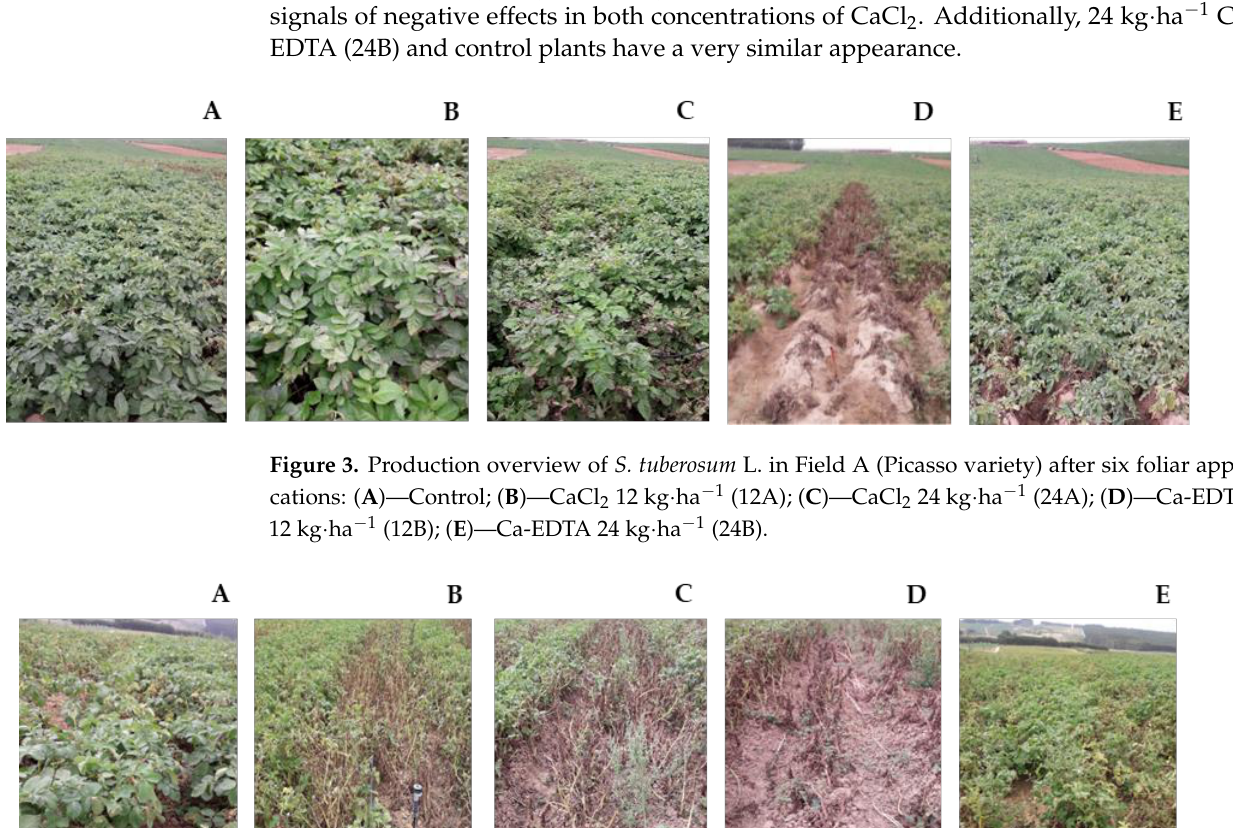
Figure 2. Orthophotomaps ( A , C ) and NDVI models ( B , D ) of S. tuberosum L. fields (Fields A— Picasso variety and B—Agria variety), after four and six foliar applications, respectively. In Field A, the information was collected four days after the fourth foliar application, and in Field B, six days after the sixth foliar application. The indication (in black) of field limits in the maps. Regarding the NDVI models, varying from −1 to 1, the color red corresponds to −1 (soil), and the color green corresponds to 1 (higher plant vigor).